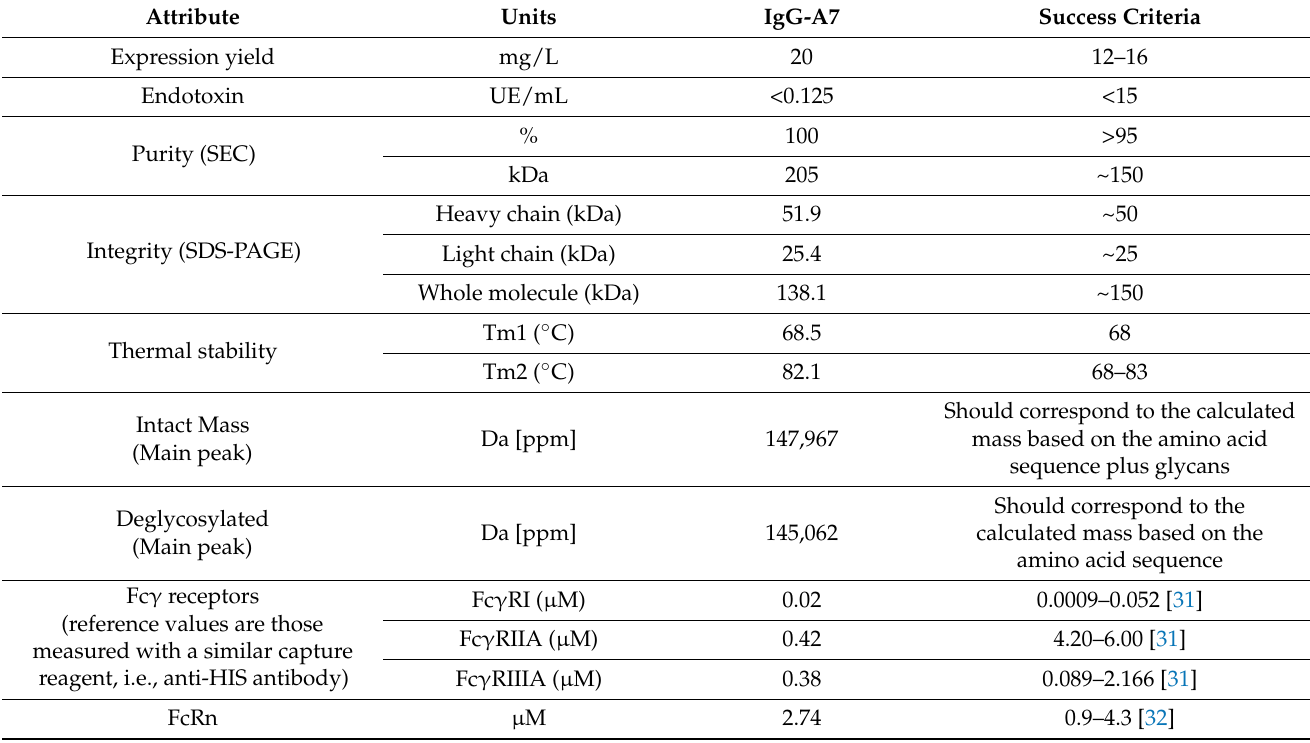
Table 1. Summary of IgG-A7 developability profile.